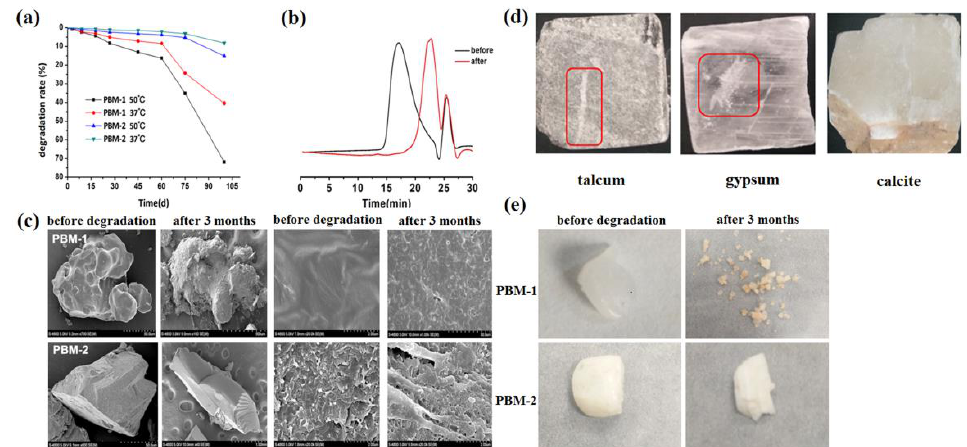
Figure 6. Degradation of PBM. ( a ) The mass loss curves of PBM at 37 °C and 50 °C; ( b ) the GPC curves of PBM-1 before and after 3 month s’ degradation at 37 °C; ( c ) the SEM images of PBM before and after 3 month s’ degradation; ( d ) the hardness of PBM-2 by scratching on different minerals; ( e ) the real pictures of PBM before and after 3 month s’ degradation.